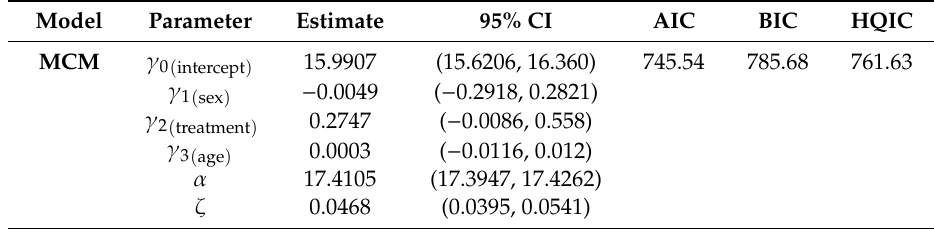
Figure 4. ( a ) Predicted population survival functions between groups calculated at median value of AGE; ( b ) predicted survival function of the uncured patients between groups, considering e1684 data. Table 4. Maximum likelihood estimate results, obtained by MCM, BCH and GNMC models with the EWE distribution for the melanoma data, and the covariates are linked all to the cure fraction parameter “ (cid:36) ” and the parameter of shape “a”.